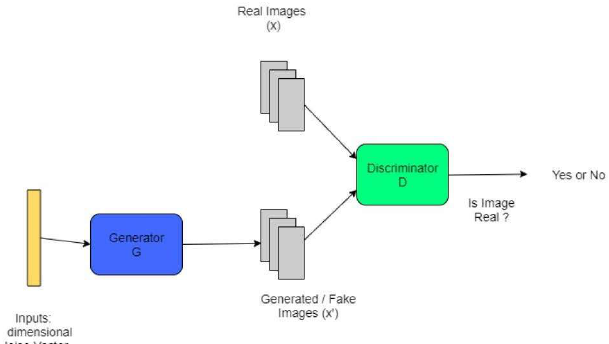
Figure 3: Architecture of Generative Adversarial Network